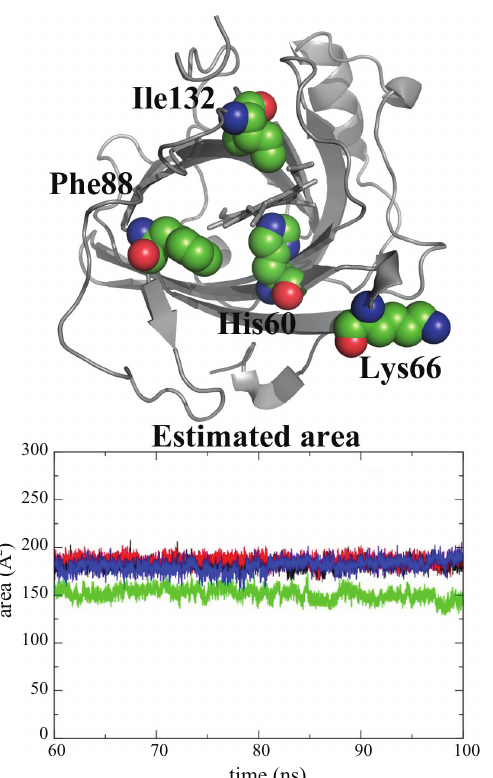
Figure S4. Time (ns) evolution of the estimated area (Å 2 ) of the heme cavity mouth determined from the triangles defined by the C α atoms of residues His60, Lys66, Phe88 and Ile132. Wild type NP7 in open and closed states is shown as red and black lines; Δ (1-3) variant in open and closed states is shown as blue and green lines.